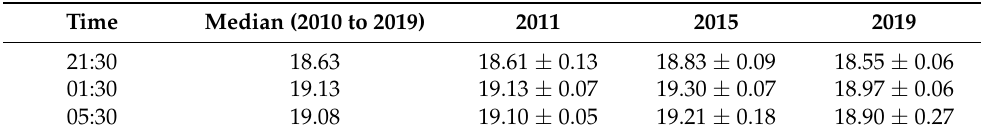
Table 3. Binned Winter Evolution in Johnson B (mag/arcsec 2 ).